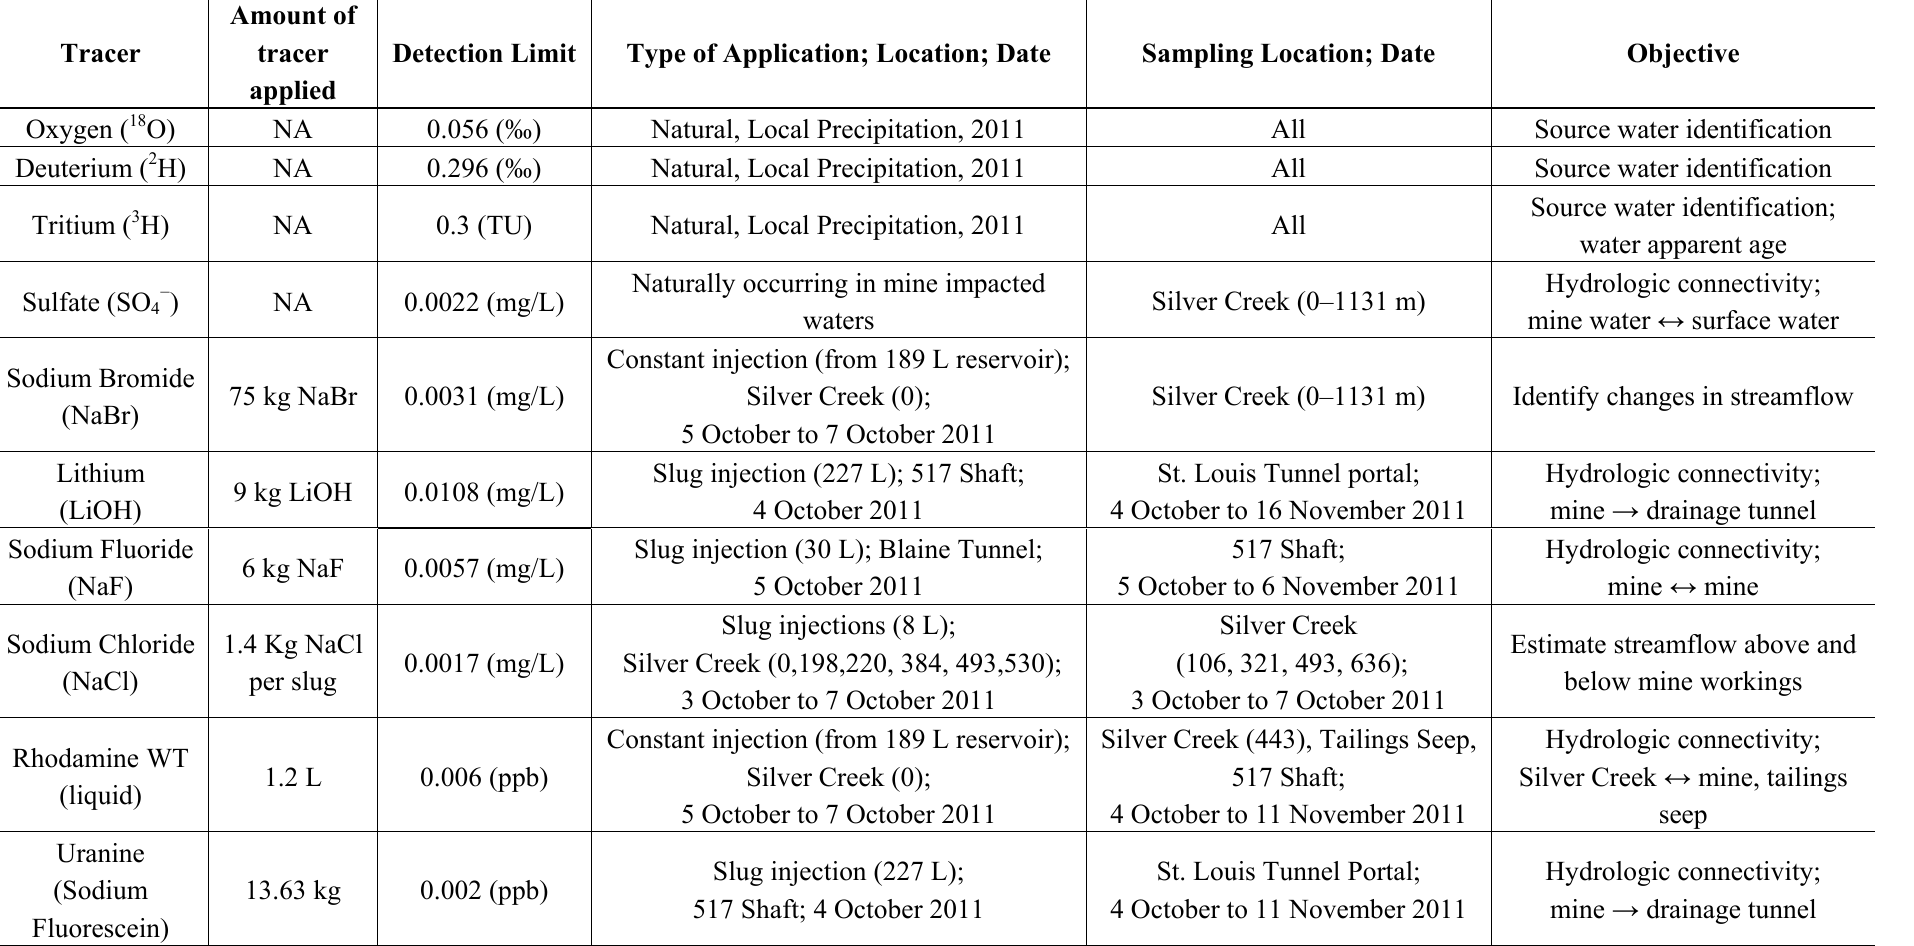
Table 1. Summary of natural and applied tracers including the amount of tracer used and the application method. Silver Creek locations are marked in Figure 1b. Detection limits for stable isotopes reported as twice the precision. (TU, tritium